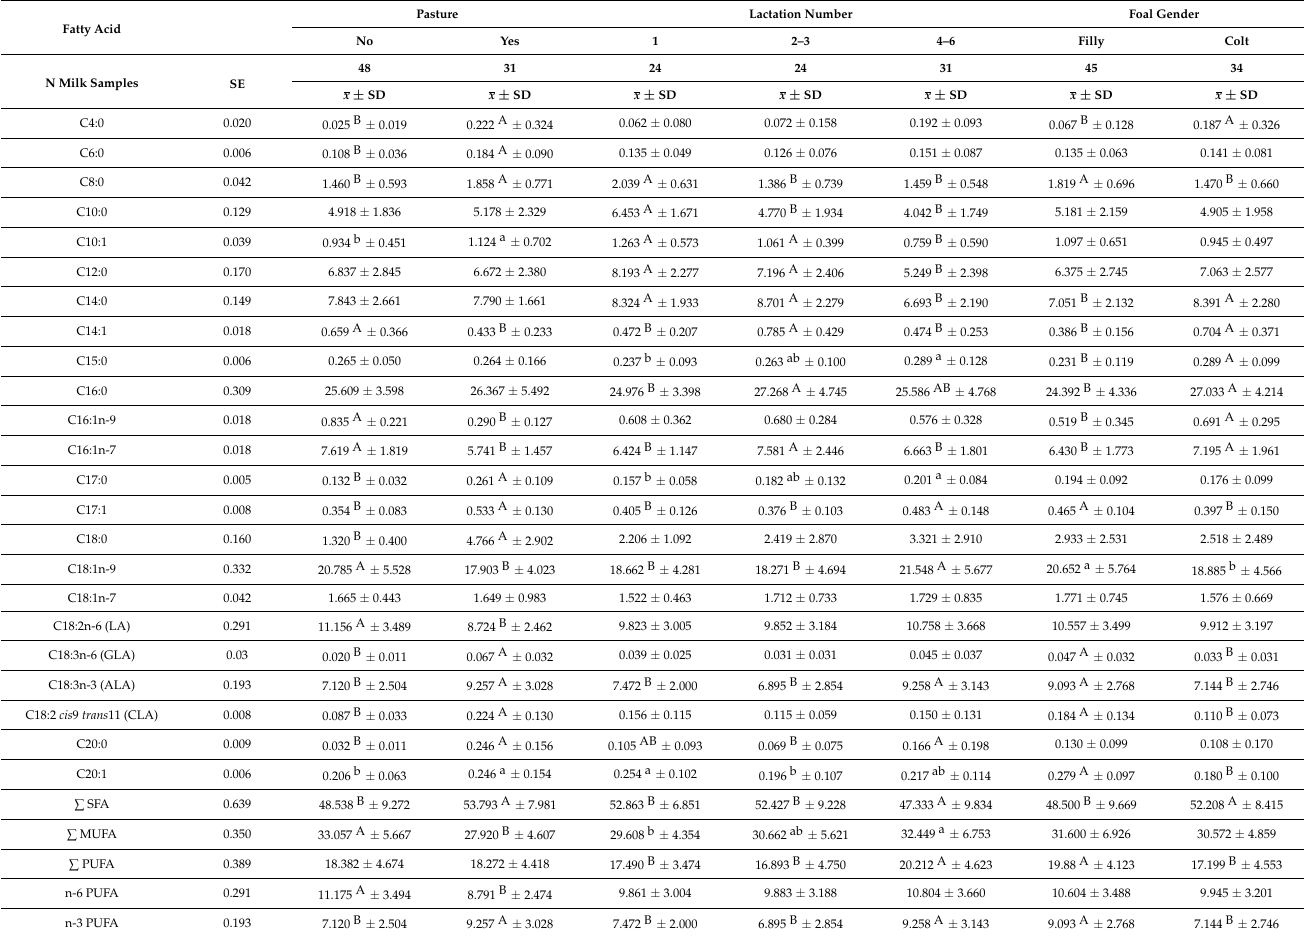
Table 4. Fatty acid profile of horse milk (g/100 g total fatty